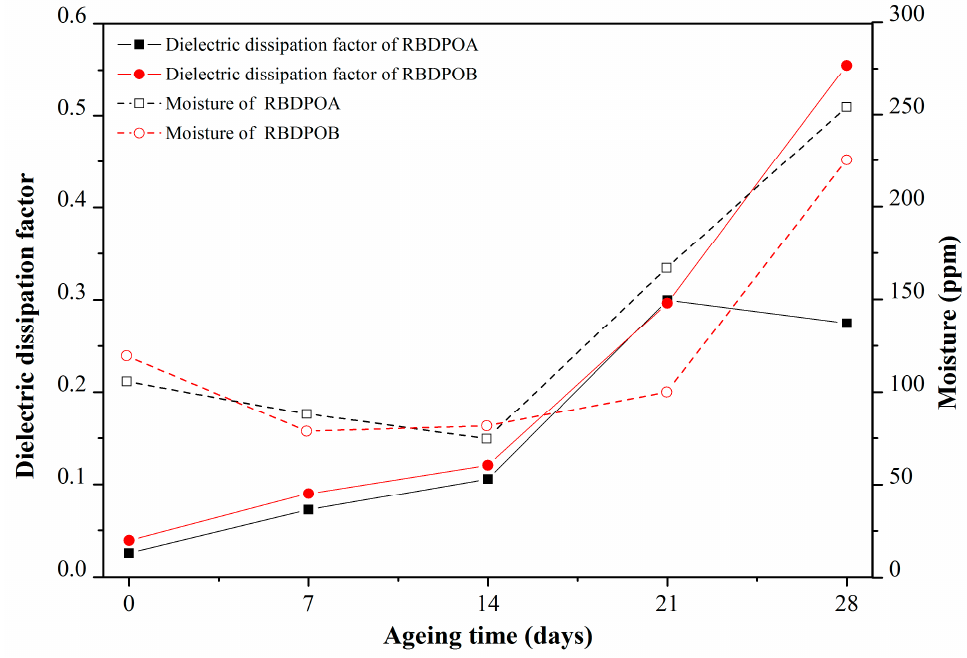
Figure 11. Relationship between dielectric dissipation factor and moisture of RBDPO aged at 170 °C under open conditions.